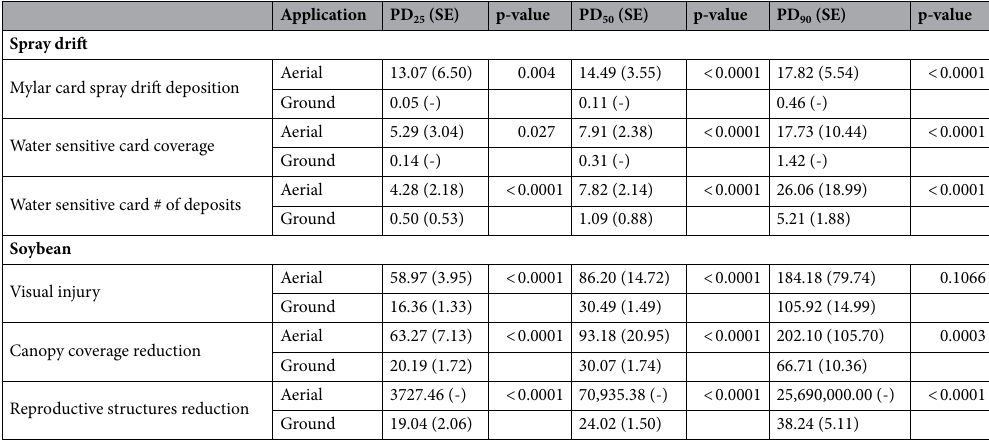
Table 2. Predicted downwind distances to observe 25, 50, and 90% reductions in spray drift potential (PD 25 , PD 50 , and PD 90 , respectively) derived from four parameter log-logistic regressions used to model spray drift and resulting soybean response from ground and aerial applications of florpyrauxifen-benzyl.